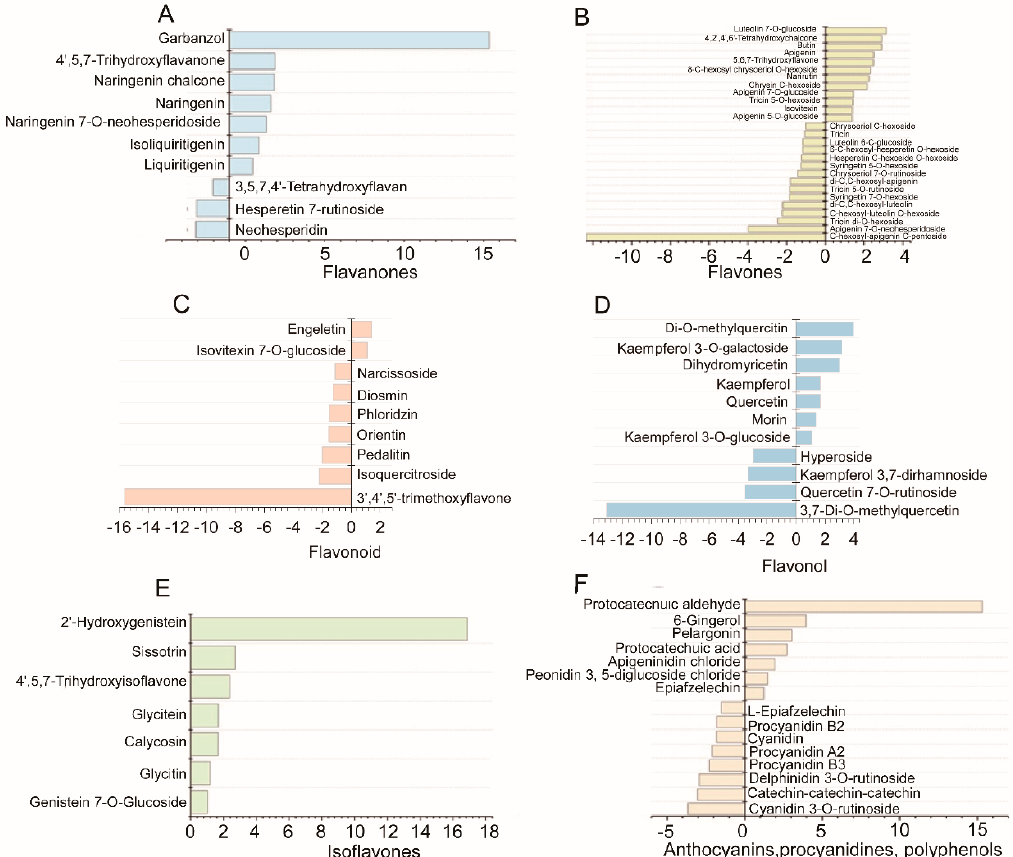
Figure 5. Significant differential flavonoids metabolites in WS and CS. ( A – F ) indicate the log2-fold-change of flavanones, flavones, flavonoid, flavonol, isoflavones and anthocyanins, procyanidines polyphenol, respectively, in WS versus CS.